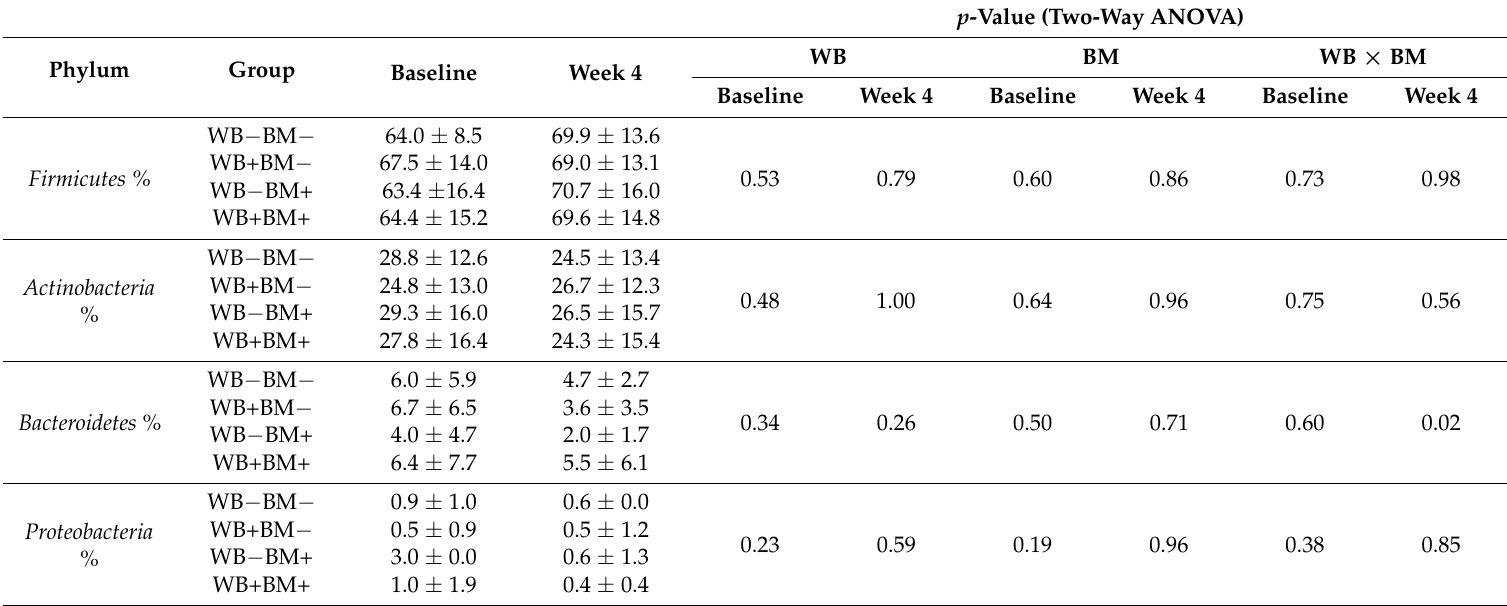
p -Value (Two-Way